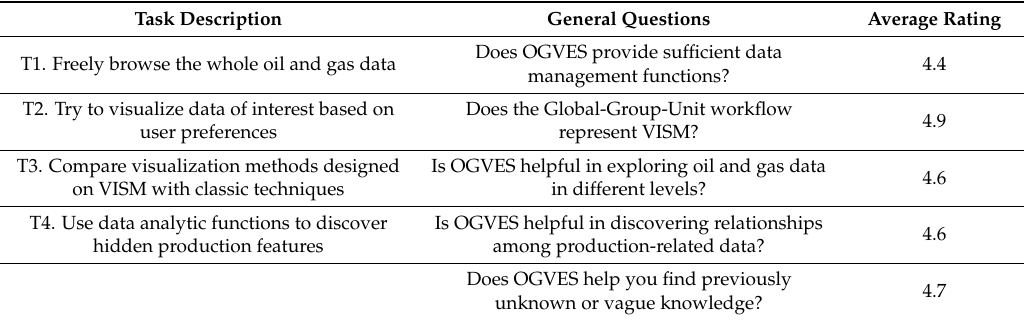
Table 2. Four tasks in the user study and users’ responses to summarized